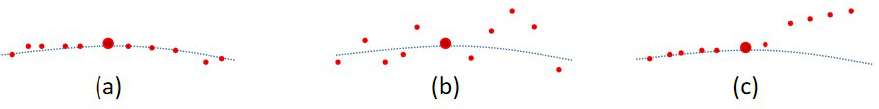
Figure 5. ( a ) Possible situation of real ground points. ( b ) Possible situation of grass points. ( c ) Possible situation of road edge points (where the big red circle is the tested scanning point, and the small red circles are its neighborhood